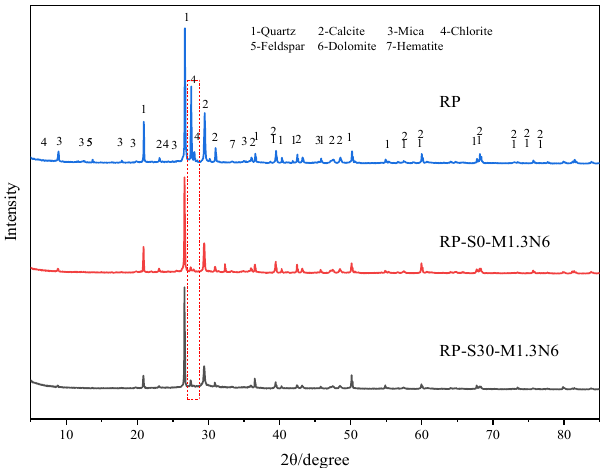
Figure 17. RD patterns of RPSG with different slag contents.